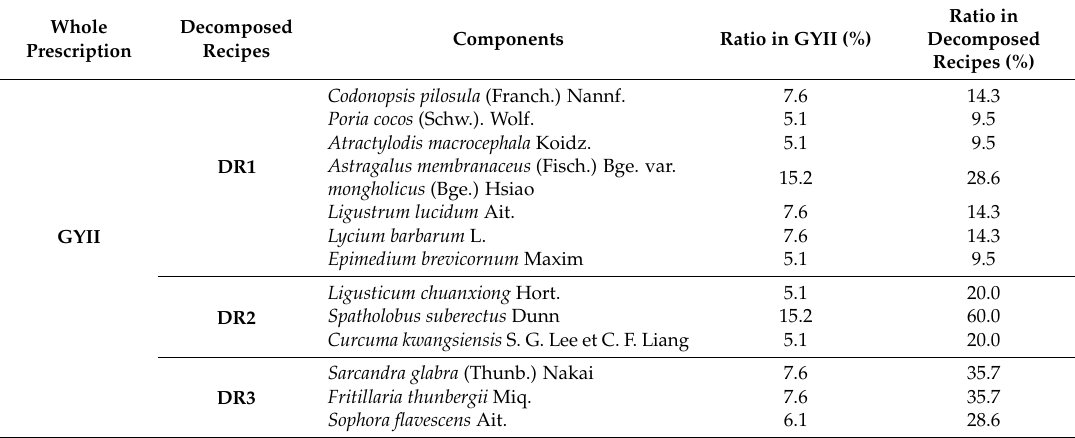
Table 1. Herbal composition of GYII and its decomposed